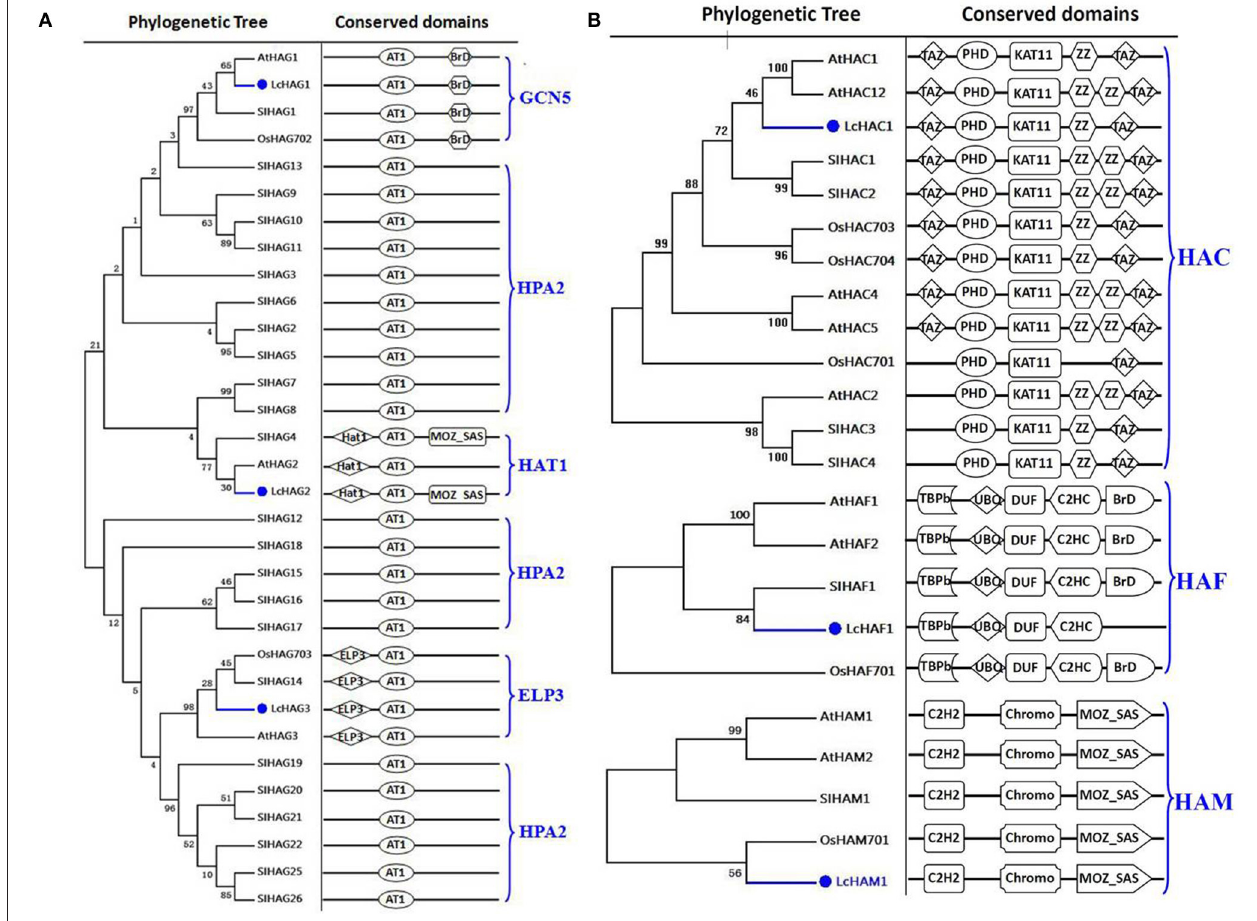
FIGURE 1 | Maximum likelihood phylogenetic trees and schematic diagrams for domain composition of HAT proteins predicted from Litchi chinensis (Lc), Arabidopsis thaliana (At), Oryza sativa (Os), and Solanum lycopersicon (Sl). (A) Phylogenetic tree and schematic diagrams for domain composition of HAG group. AT1 (PF00583) and C-terminal BrD (PF00439) are conserved domains of GCN5-like members; N-terminal ELP (IPR006638), and C-terminal AT1 are domains of ELP3-like; N-terminal Hat1_N (PF10394) and C-terminal AT1 are motifs of HAT1-like members while the only AT1 domain is of HPA2-like